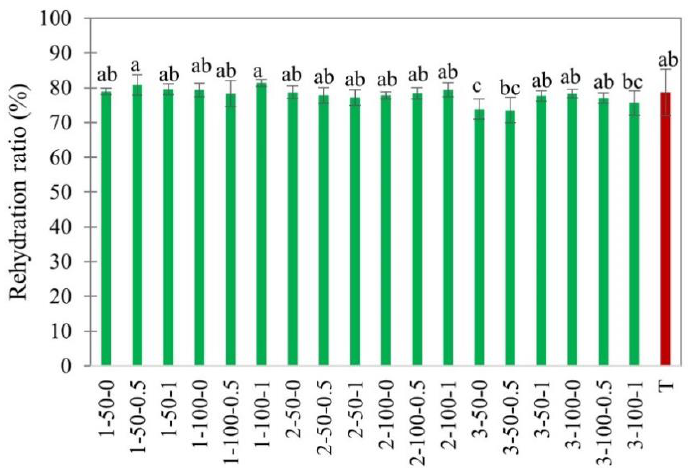
Figure 11. Rehydration ratio of EHD (marked in green and labeled as thickness-slice load density- airflow) and hot air-dried (marked in red as T) apple slices. Different lower-case letters indicate statistically significant differences ( p < 0.05).